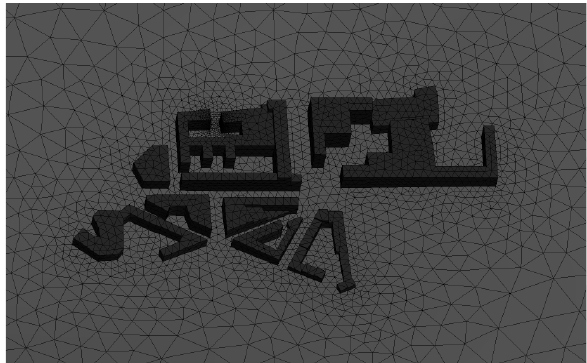
Figure 6. Boundary mesh of buildings.